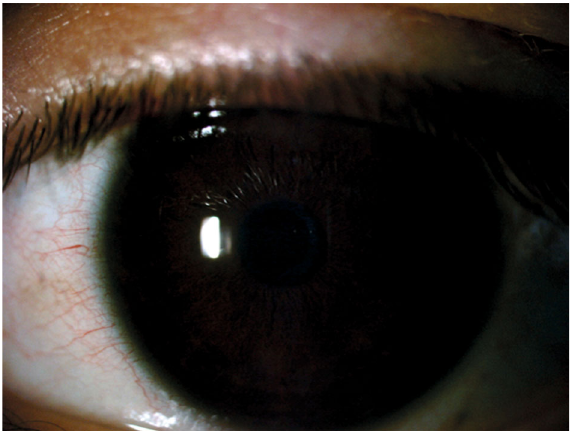
Figure 1: Left eye one week after surgery, with an uneventful clinical